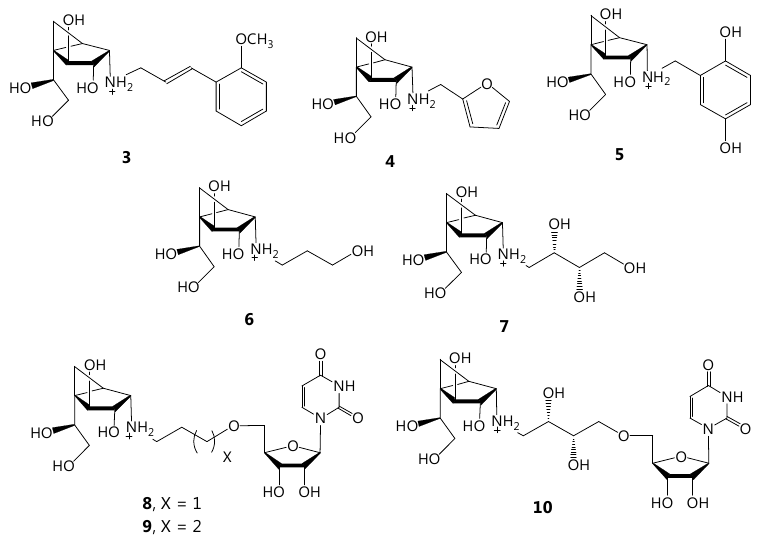
Figure 2. Target mimics of UDP-Gal f ( 1 ), based on the bicyclo[3.1.0]hexane derivative 2 .